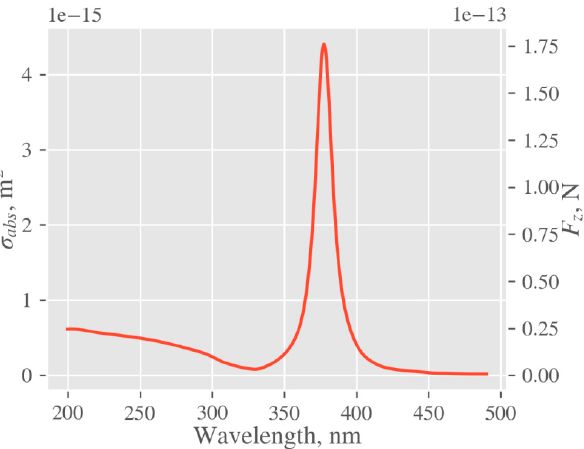
Figure 11. Absorption cross section ( σ abs ) and optical force ( F z ) of the modeled silver nanoparticle calculated in Z -direction according to Mie theory.